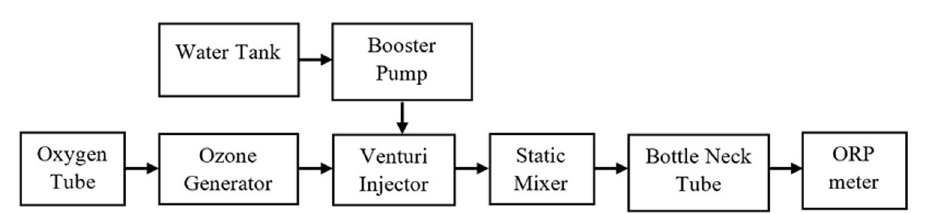
Fig. 2. Experimental setup